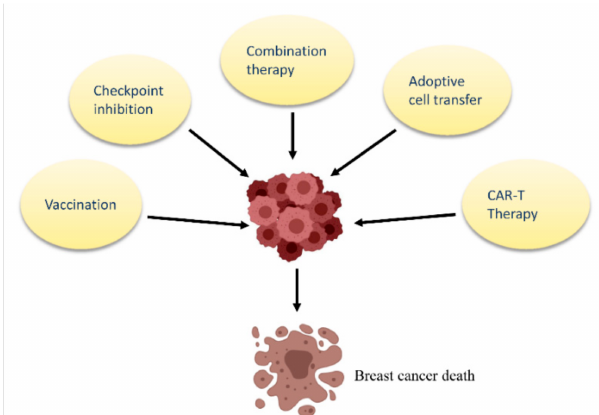
Figure 3. Current immunotherapeutic strategies against breast cancer. Clockwise. Vaccination involves the use of tumor antigens or other immunogenic molecules to stimulate anti-tumor immune response. Checkpoint inhibition is an immunotherapeutic approach which inhibits checkpoint molecules using antibodies, thereby enhancing anti-tumor immune response. Combination therapy : chemotherapeutic agents are combined with checkpoint inhibition to enhance anti-tumor immune response. Adoptive cell transfer of expanded tumor specific immune cells has shown potent anti-tumor activity.